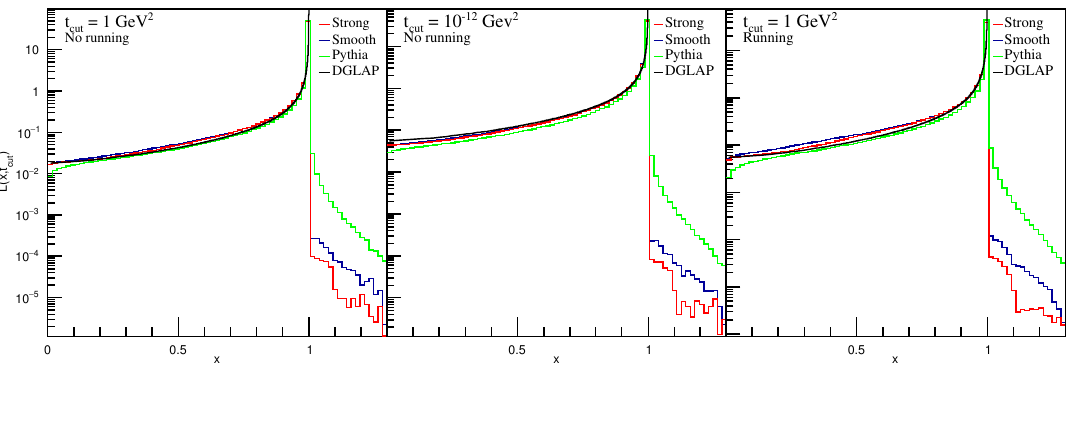
Figure 9 . Comparison between a numerical solution to the DGLAP equation, the sector shower approach and the default Pythia shower. In the left and middle pane, the coupling (cid:11) is kept (cid:12)xed at its value at the electron mass, while the cuto(cid:11) scale is varied. On the right, (cid:11) is allowed to